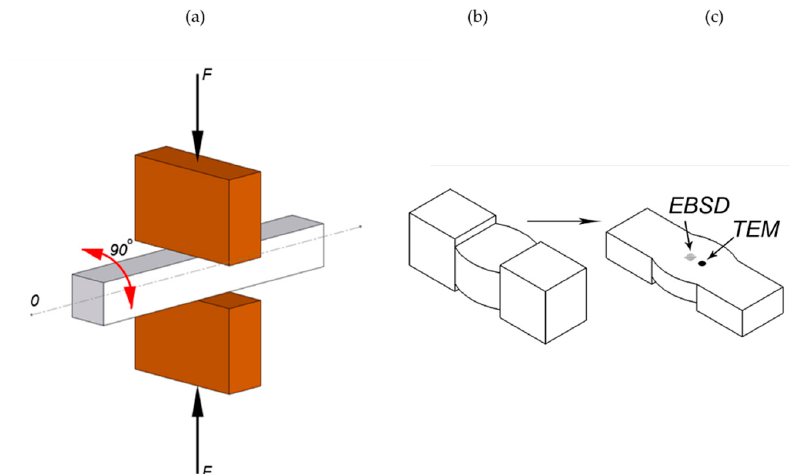
Figure 1. Scheme of the MaxStrain experiment ( a ); specimen after deformation ( b ); positions of the EBSD and TEM studies in the specimens deformed with the MaxStrain system ( c ).